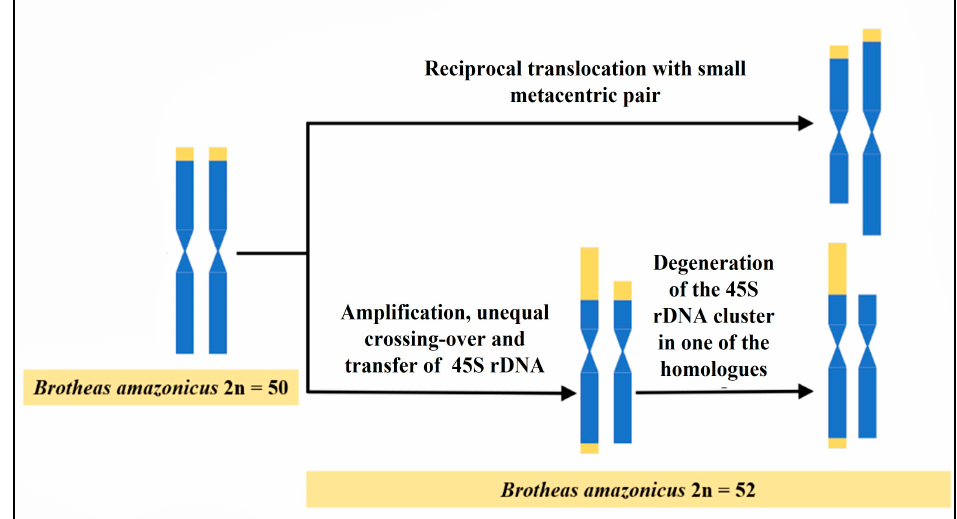
Figure 6. Hypothesis for the evolution of 45S rDNA clusters in B. amazonicus cytotypes.